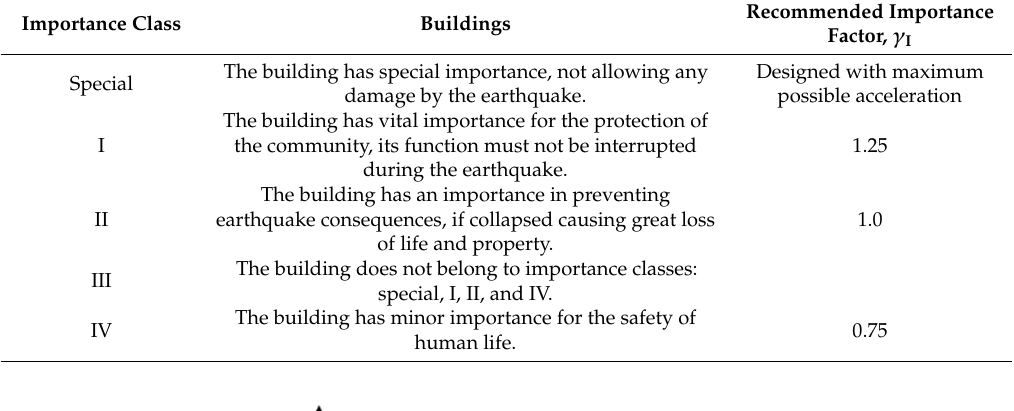
Figure 2. Ground acceleration map for ( a ) Vietnam [4] and ( b ) Hanoi.